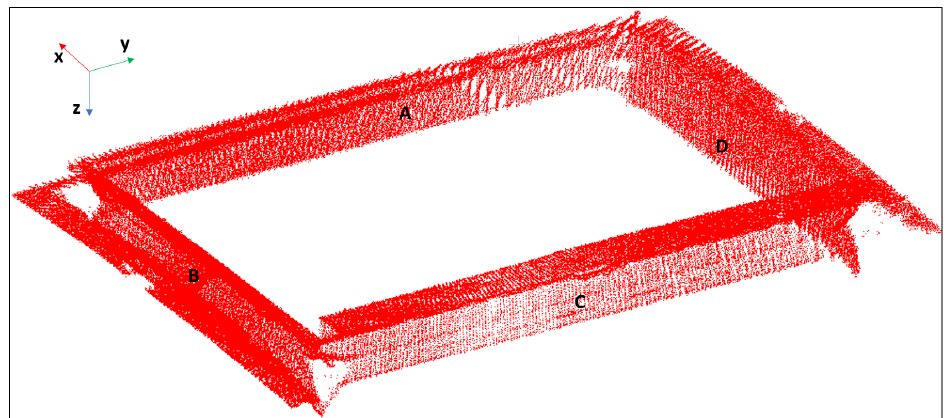
Figure 7. Example of voxelized point cloud after circular scanning in a near-empty hatch. The symbols B and D (A and C) mark the minimum and maximum hatch edges in the y-direction (x-direction).